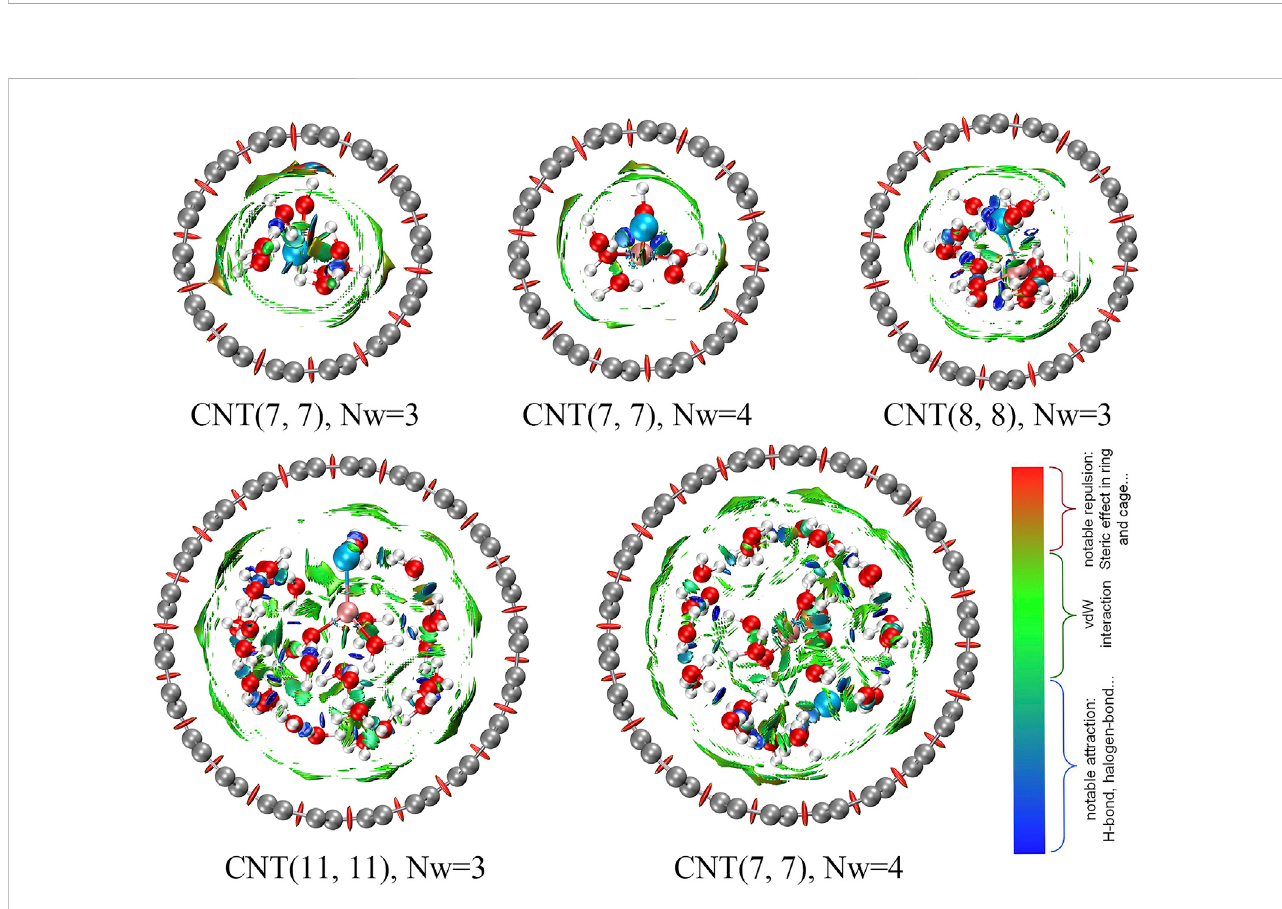
FIGURE 6 Interaction picture among ions obtained by the non-covalent interaction (NCI)